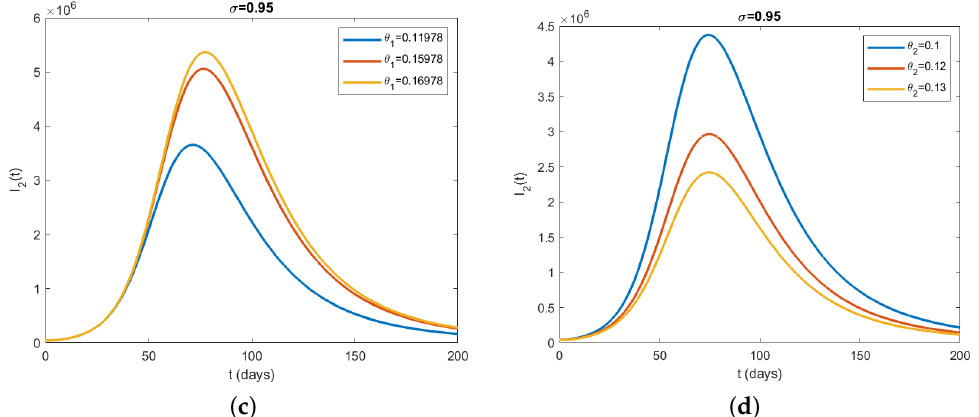
Figure 5. Effect of the model parameters ( a ) β 1 , ( b ) β 2 , ( c ) θ 1 , and ( d ) θ 2 on I 2 individuals with fractional order σ =